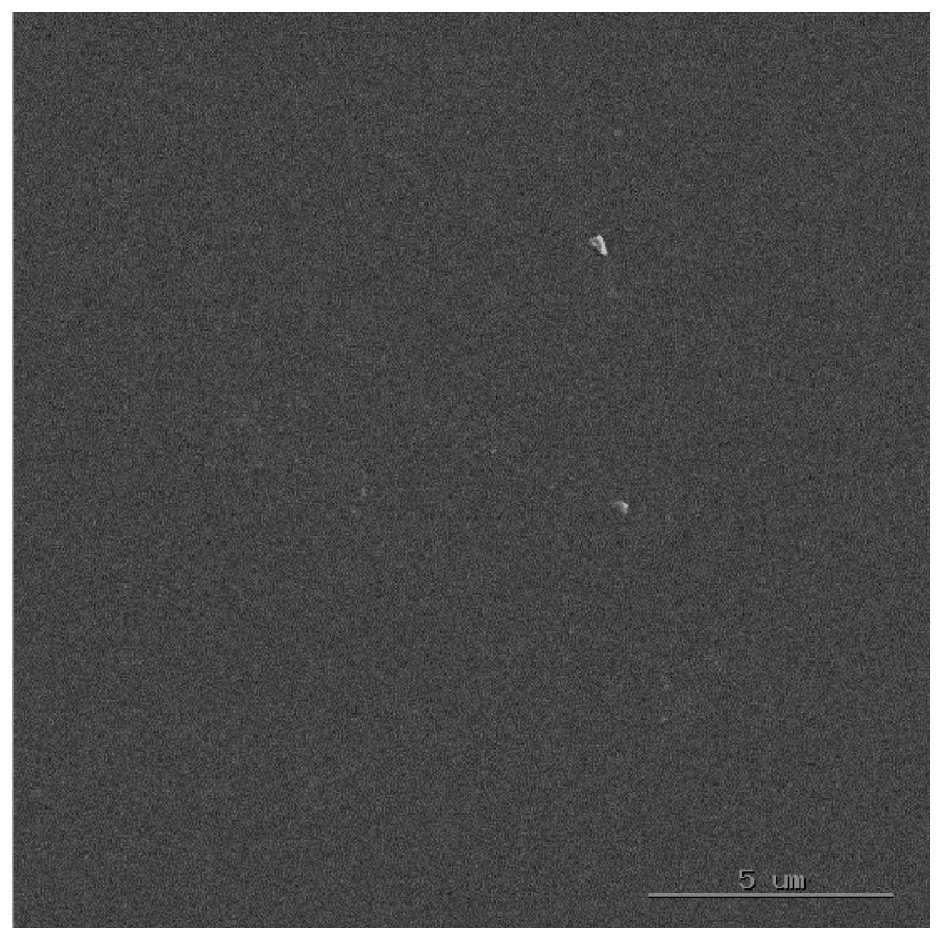
FIGURE 9 SEM for quenched sample of n -Si from 600 (cid:1) C with scale of 5